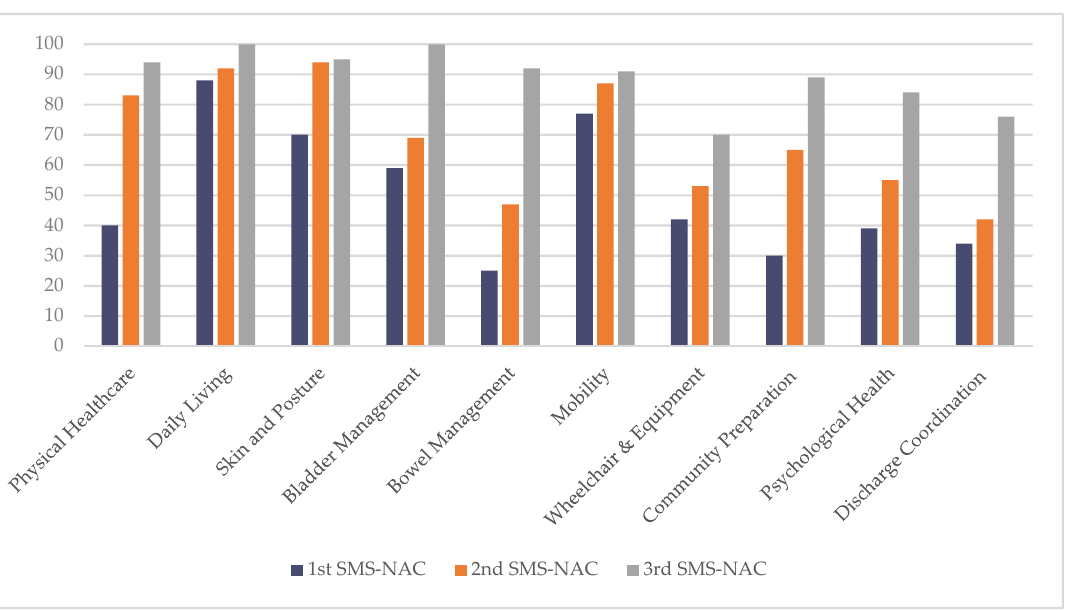
Figure 5. Petran’s first, second and third SMS-NAC percentage scores across outcome domains. Qualitative user testimony about the programme was collected as part of the patient experience leaflets developed for users and explanatory and training films. The following are some excerpts: